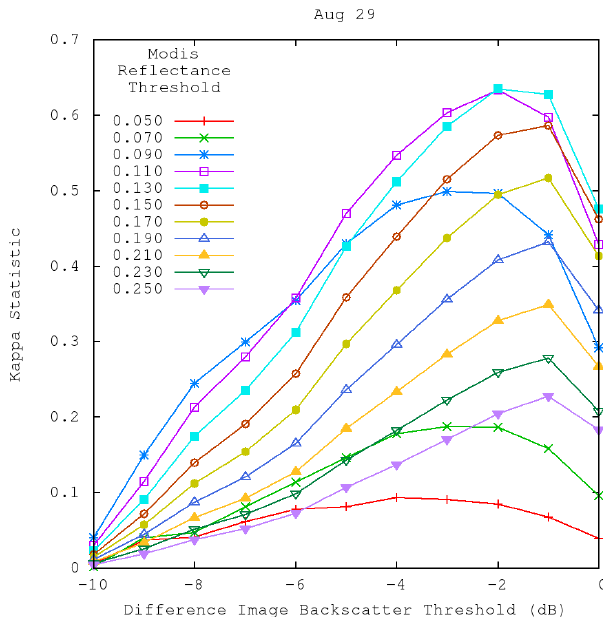
Fig. 13. κ statistic calculated for individual classifications of flood- ing on 29 August 2010, based upon 1σ 0 thresholds ranging from − 10 to 0dB. The series represents corresponding MODIS Band 6 reflectance thresholds used in the reference image, ranging from 0.05 to 0.25.